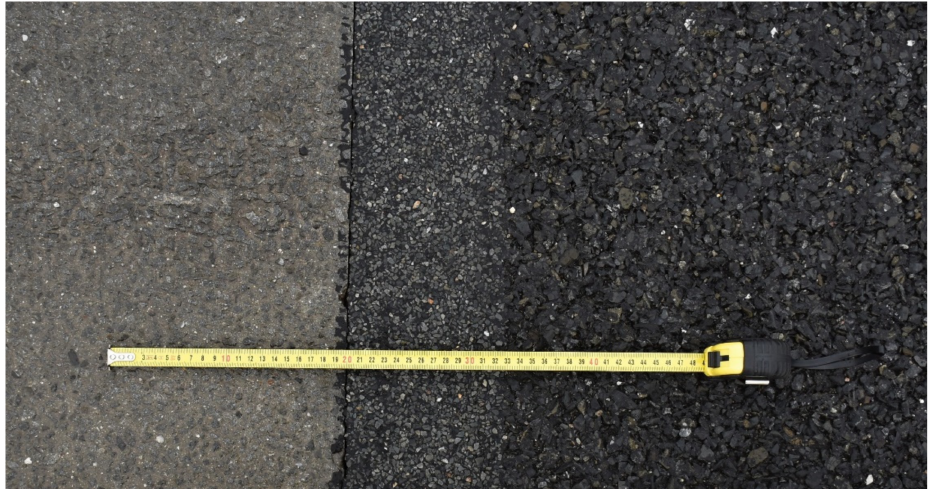
Figure 4. The exposed aggregate cement concrete surface with the highest grain size of 8 mm (EEAC 8) on the left and stone mastic asphalt surface with increased resistance to permanent deformation with the highest grain size of 11 mm (SMA 11S) on the right (source: